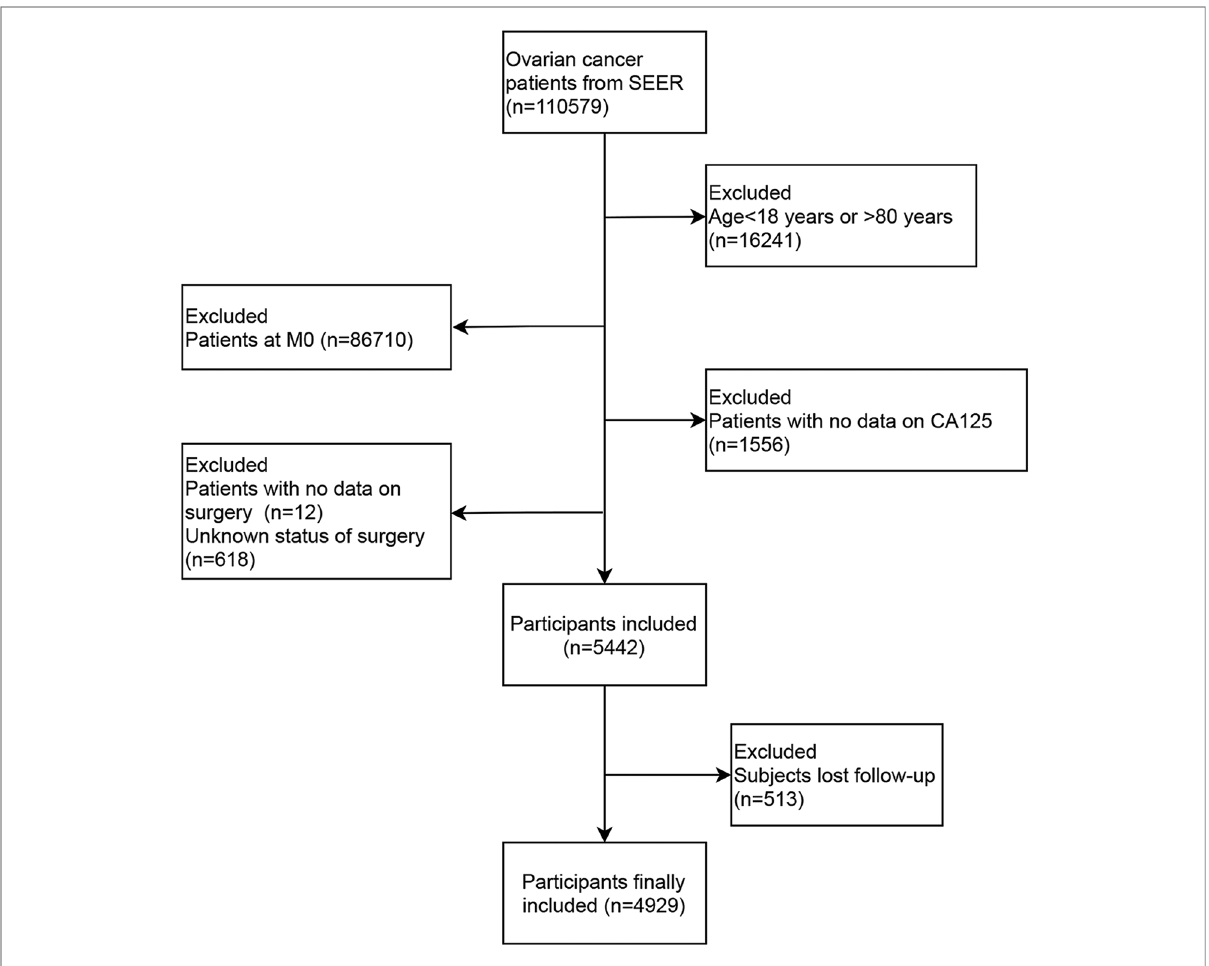
FIGURE 1 The screen process of the participants in this